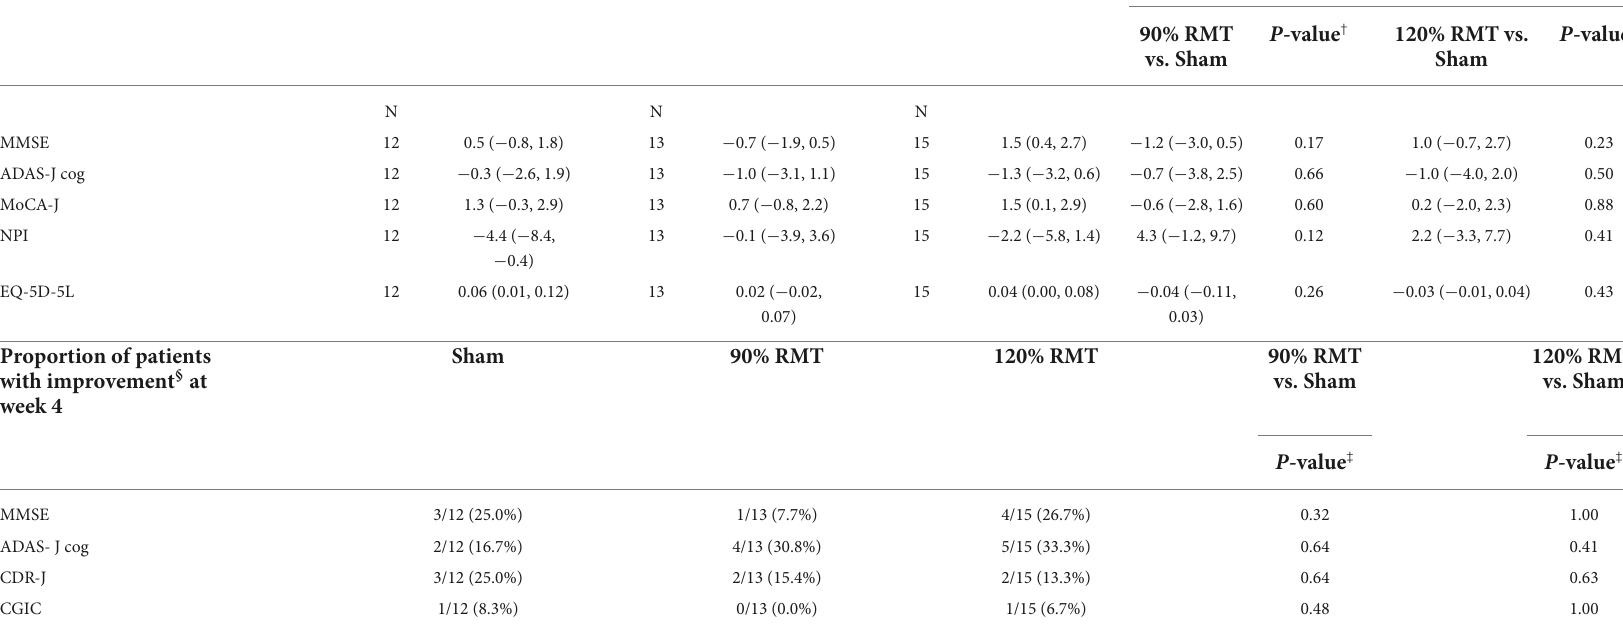
TABLE 4 Efficacy outcomes in as treated. Adjusted mean change from baseline (95% CI) at week 4